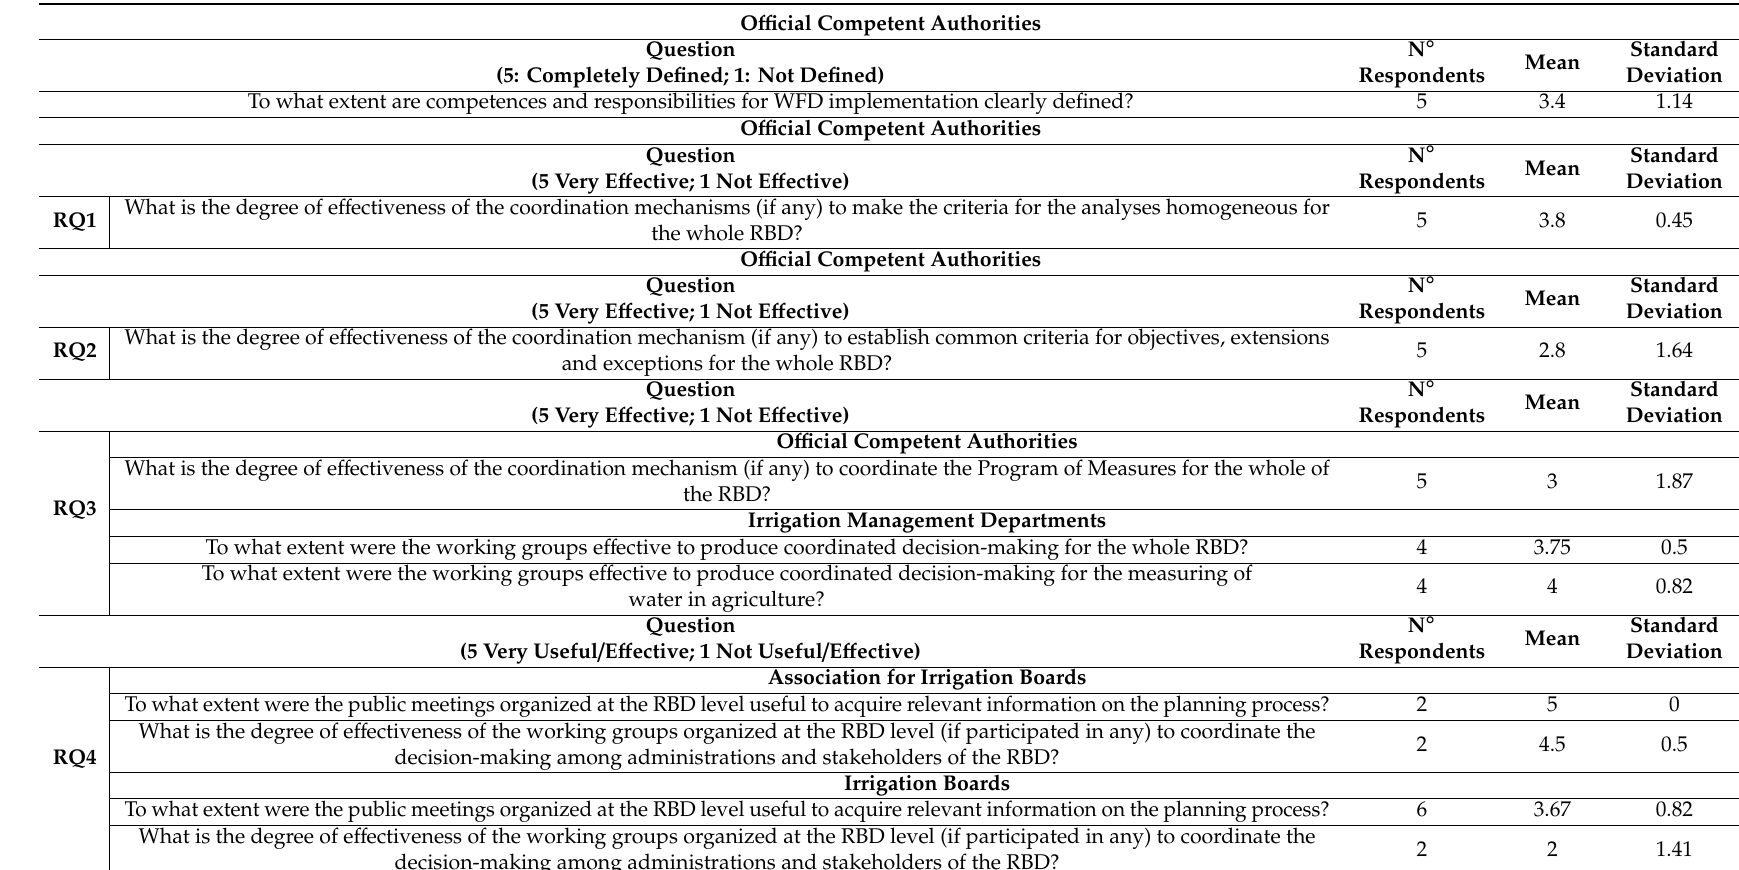
Table A1. Descriptive statistics of closed-ended